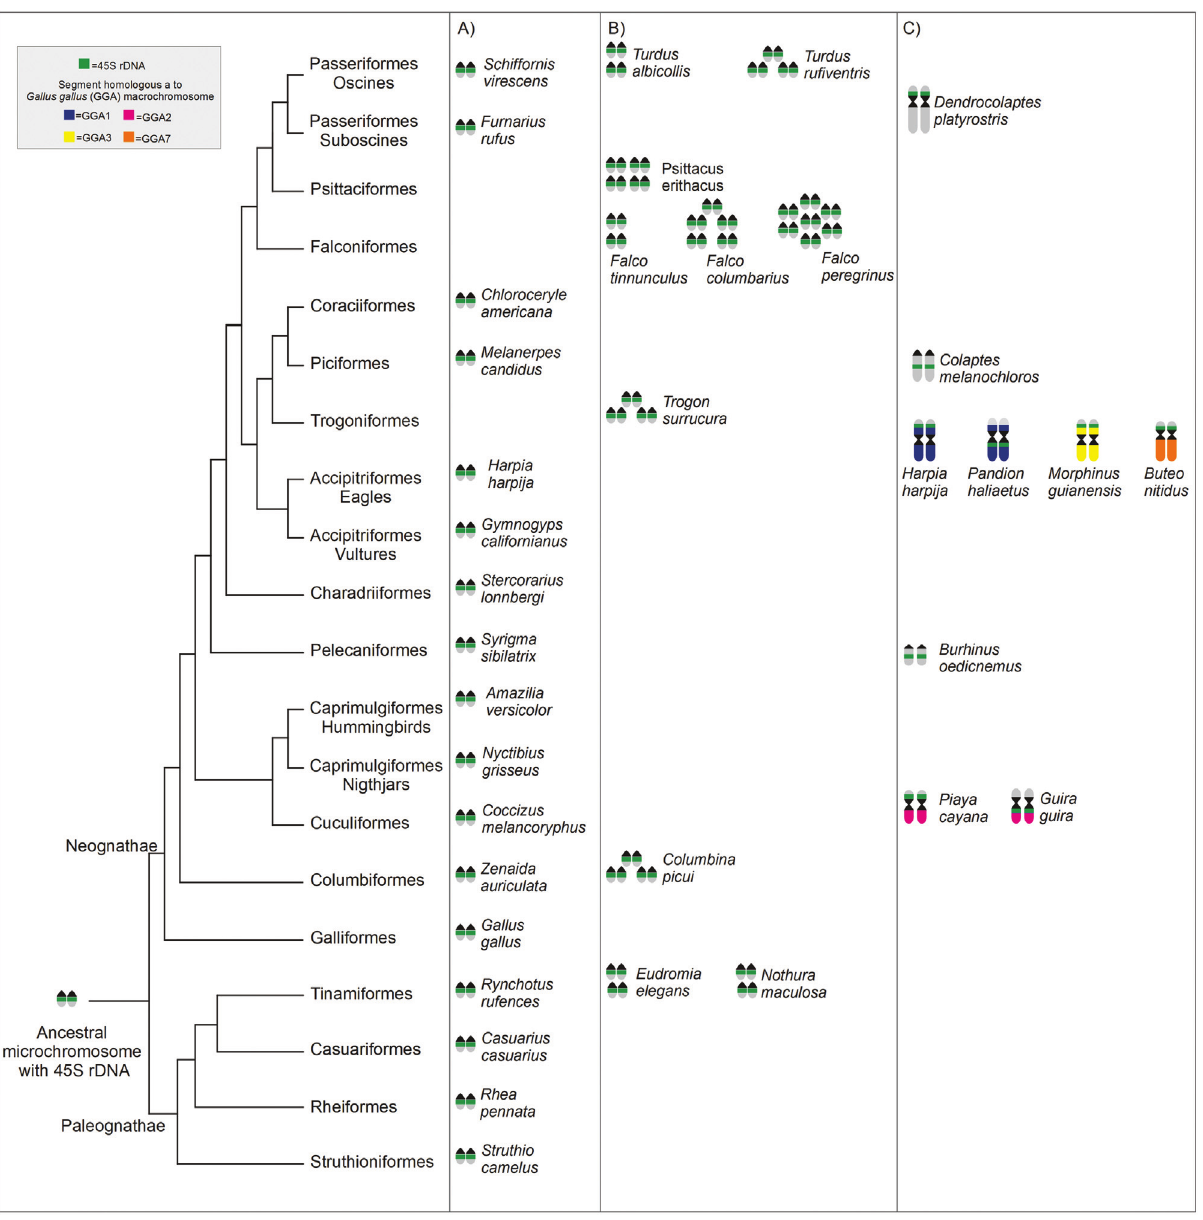
Figure3 -PhylogeneticrelationshipsamongthebirdsmodifiedfromJarvis etal. ,2014.Thedataofchromosomallocationofthe45SrDNAfromspecies analyzed in the present study were plotted in the tree. (A) Species with rDNA located only in a microchromosome pair; (B) species with rDNA in multi- ples microchromosomes; (C) species in which the rDNA is located in macrochromosomes. The complete data are shown in Table